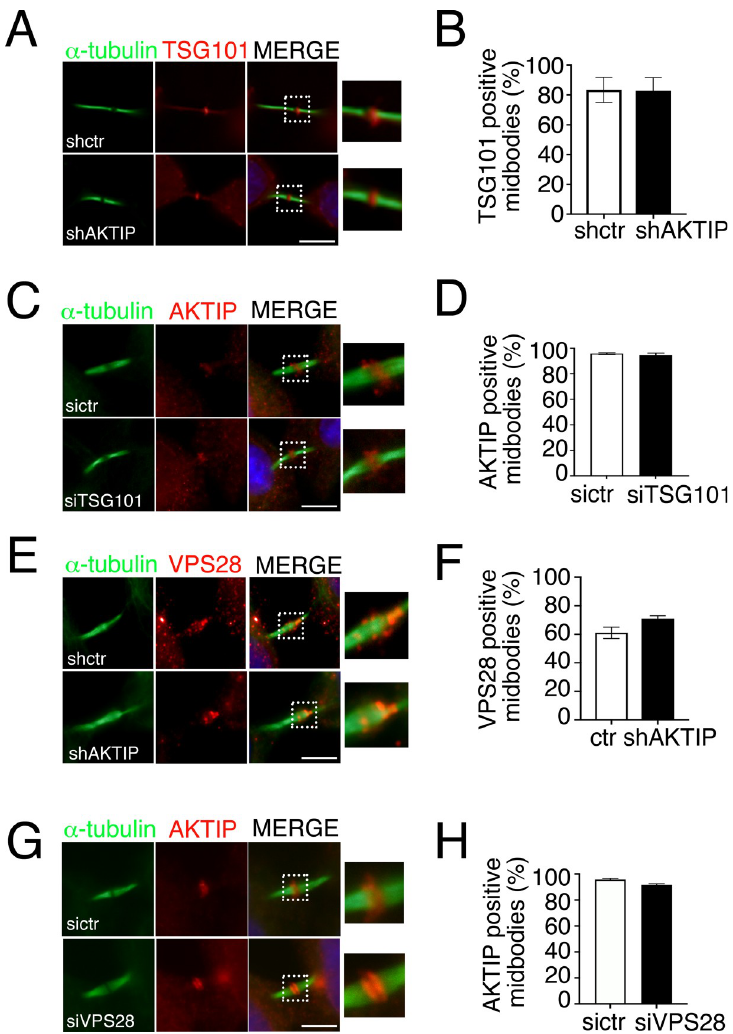
TSG101 is present at the midbody in shAKTIP cells. (C-D) Representative images and relative quantification of sictr and siTSG101 HeLa cells stained for AKTIP (red) and α -tubulin (green) showing that AKTIP is present at the midbody in siTSG101 cells (E-F) Representative images and relative quantification of shctr and shAKTIP HeLa cells stained for VPS28 (red) and α -tubulin (green) showing that VPS28 is present at the midbody in shAKTIP cells. (G-H) Representative images and relative quantification of sictr and siVPS28 HeLa cells stained for AKTIP (red) and α - tubulin (green) showing that AKTIP is present at the midbody in siVPS28 cells. For results in (B, D, F and H) at least 100 midbodies per conditions were counted. Scale bars, 5 μ